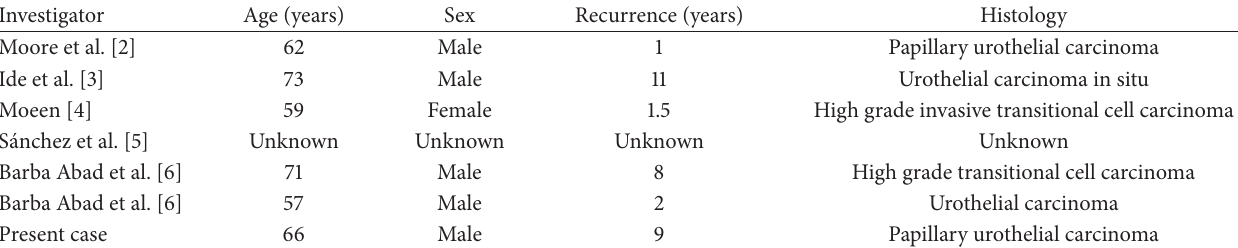
Table 1: Cases of carcinoma recurrence in an ileal